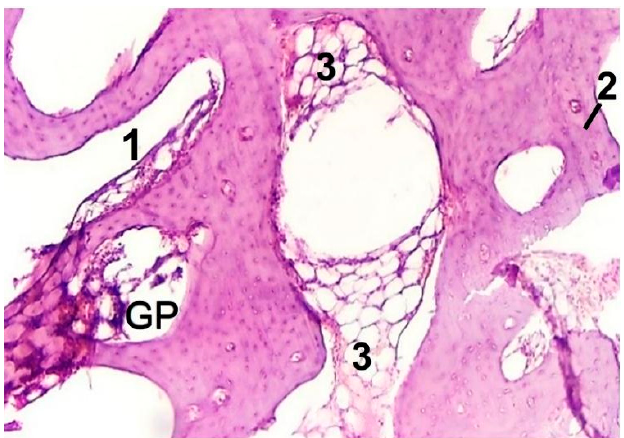
Figure 5. Histopathological sections in cortical area of femur treated with glass powder (experimental group after 2 months, original magnification 10.0×). Legend: GP—residue of bone graft with embedded osteocytes; 1—the bone marrow vascular niche; 2—old bone; 3—fat inclusions to yellow bone marrow.